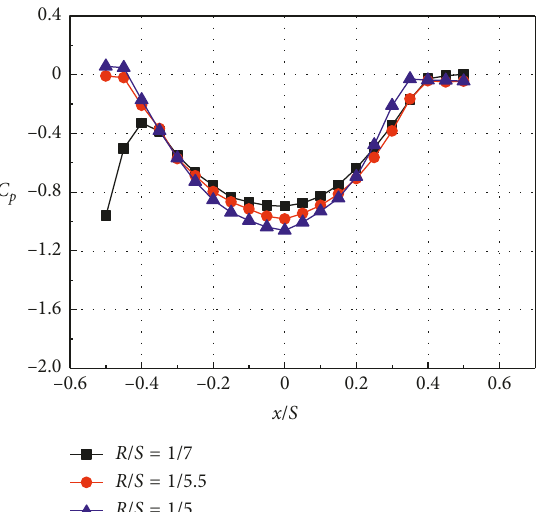
Figure 16: Mean pressure distributions on the middle transverse cross sections of cylindrical roofs with optimal and near optimal rise-to-span ratios.